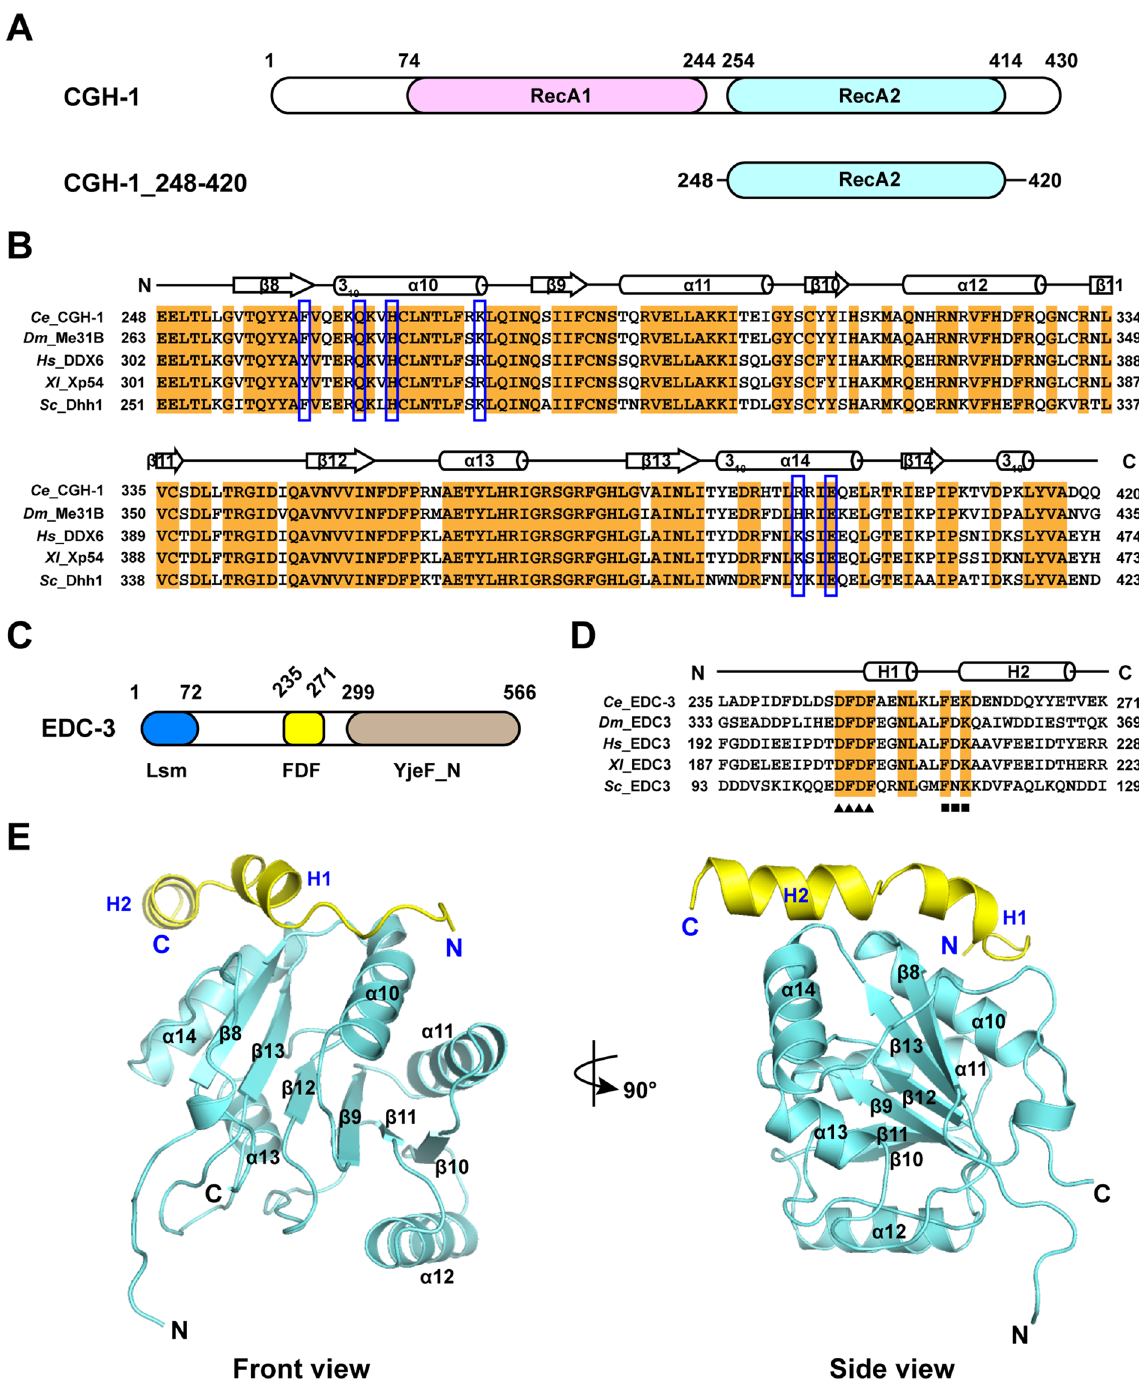
Figure 1. Structural model of CGH-1 RecA2 domain in complex with EDC-3 FDF-FEK. ( A ) Schematic view of domain architecture of C. elegans CGH-1. RecA1 and RecA2 domain are colored in violet and cyan, respectively. The construct of RecA2 domain employed in this work was also shown. ( B ) Sequence alignment of CGH- 1 248–420 and its orthologs. The residues for site-directed mutation in this study were marked with blue boxes. The secondary structures were also indicated in this panel. ( C ) Schematic view of domain architecture of C. elegans EDC-3. LSm domain, FDF domain, and YjeF-N domain are colored in blue, yellow and brown, respectively. ( D ) Sequence alignment of Ce EDC-3 235–271 and its orthologs. DFDF and FxK are represented by triangles and squares, respectively. The second structures were also shown in this panel. ( E ) Overall view of this model shown in cartoon. CGH-1 RecA2 domain and EDC-3 FDF are colored in cyan and yellow,